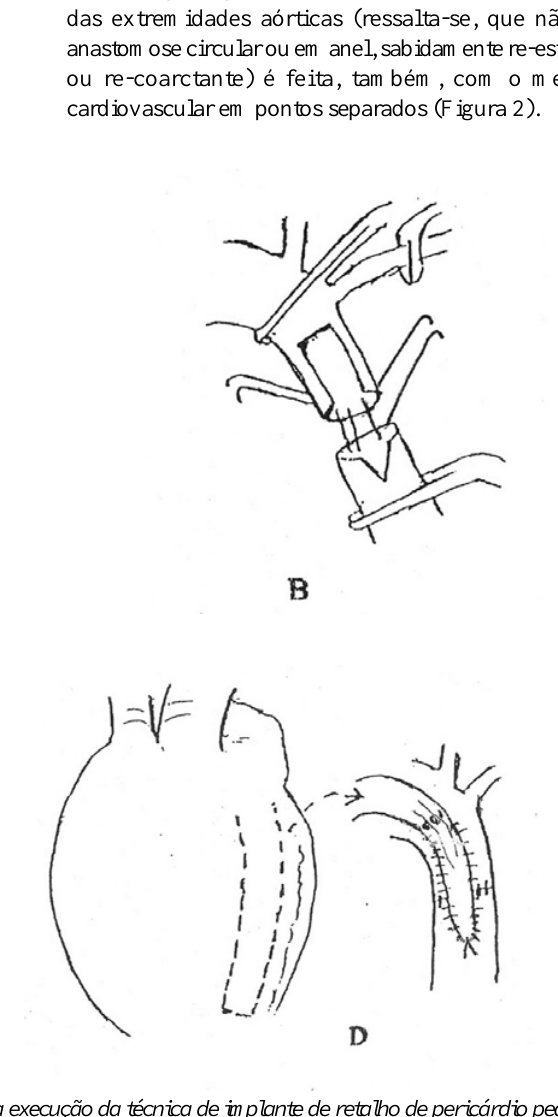
Fig. 2 – Desenho esquemático de todos os tempos cirúrgicos para execução da técnica de implante de retalho de pericárdio pediculado e vascularizado na aorta